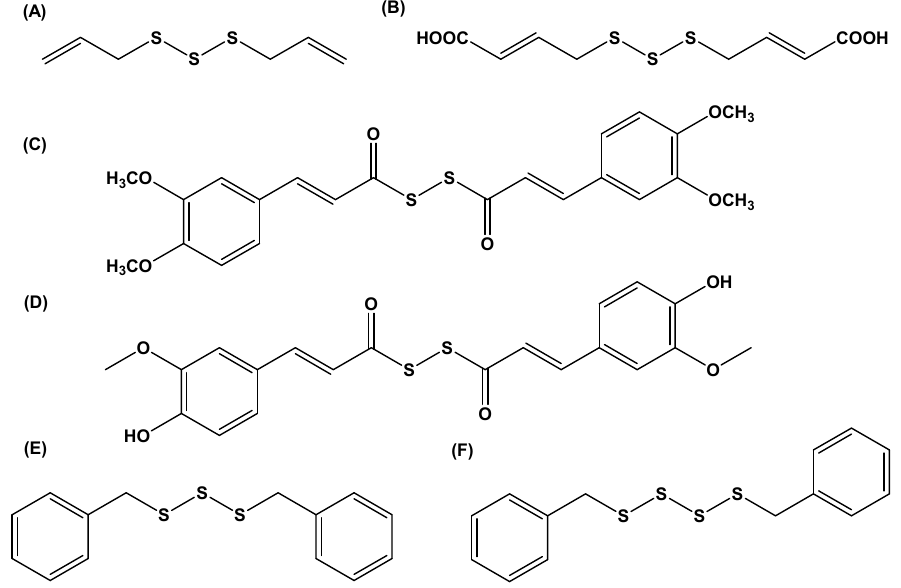
Figure 7. In recent years, interest in ( A ) DATS led to the design and synthesis of several novel